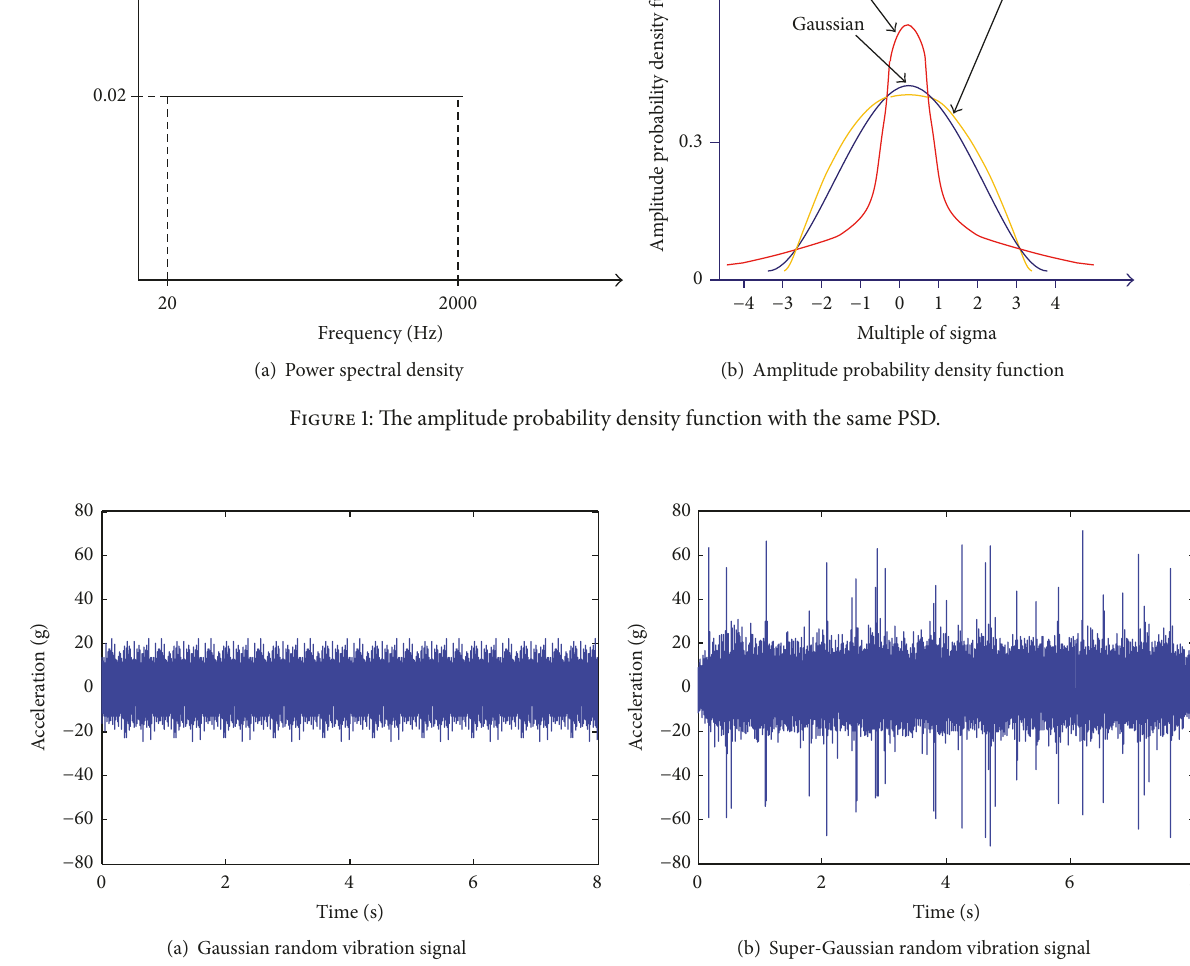
Figure 2: The difference between Gaussian and super-Gaussian random vibration